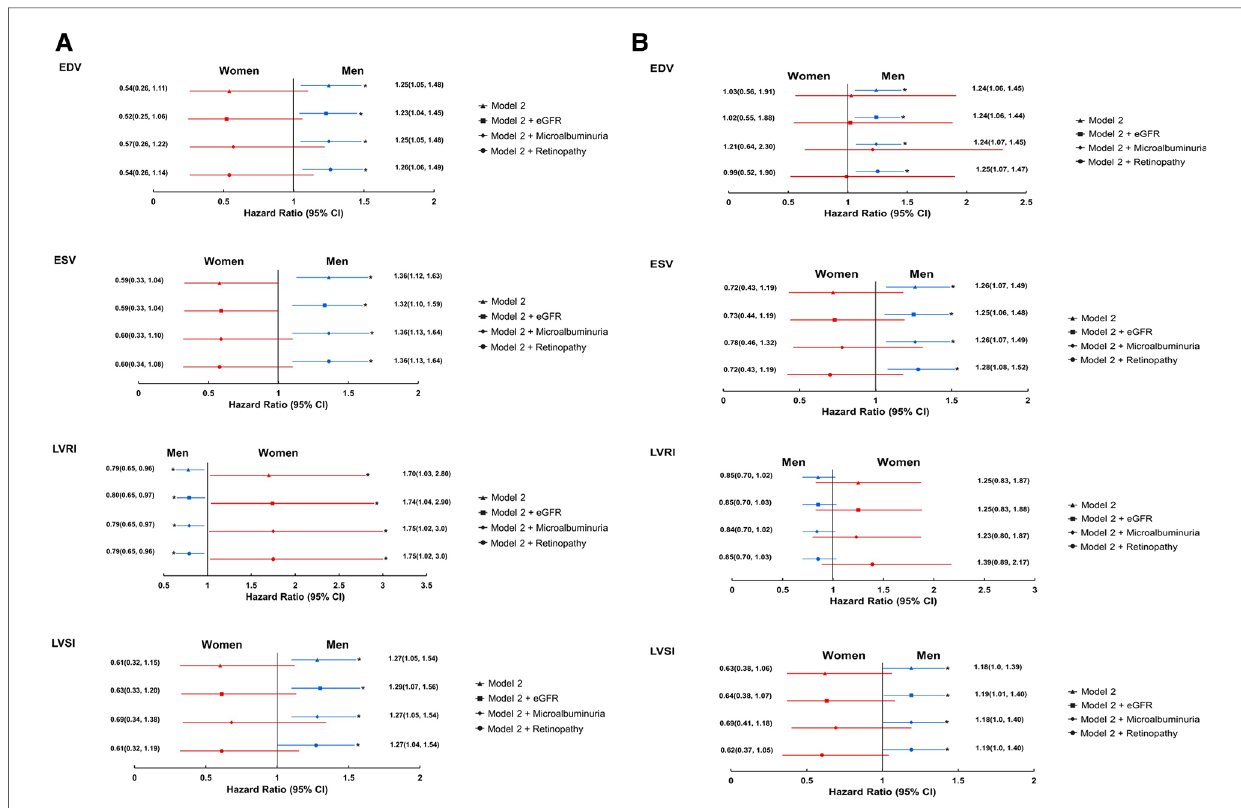
FIGURE 4 Forest plots showing the associations between 3DE-derived LV measures and all-cause mortality ( A ) and composite cardiovascular endpoint ( B ) strati fi ed by sex; role of micro-vascular disease(imputed data). *Indicates p <0.05. eGFR, estimated glomerular fi ltration rate. Remaining abbreviations as in Table 2 . Footnotes as in Figure 1